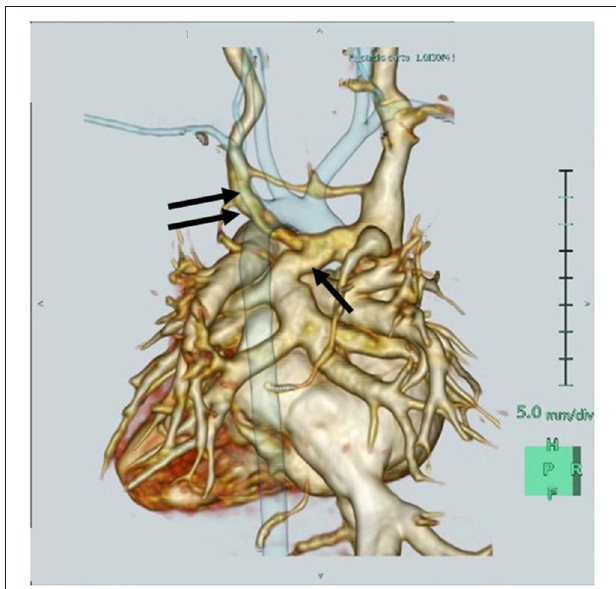
FIGURE 2 | Three-dimensional cardiac computed tomography reveals that the retroaortic innominate vein (RAIV, double arrow) passes posterior to the ascending aorta to join the superior vena cava and the vertical vein (single arrow) merges into the RAIV.